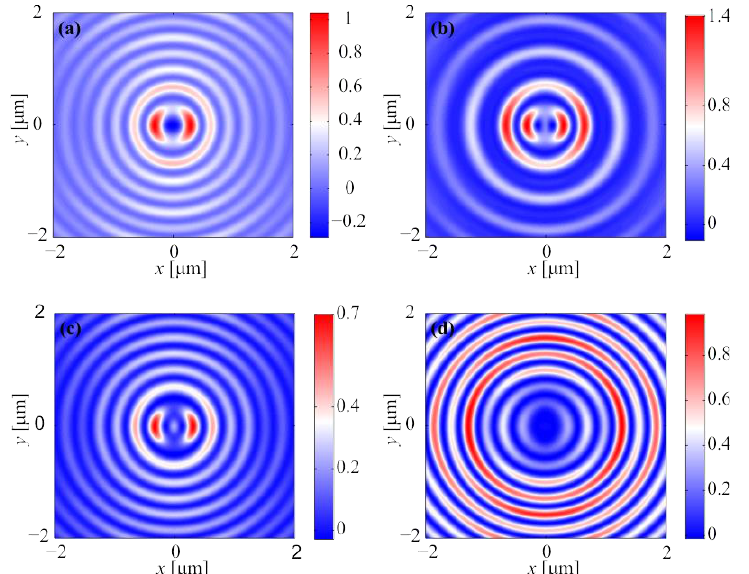
Figure 7. The instantaneous pattern of the longitudinal component of the Poynting vector S z of the second-order CVB in the focus of the BZP with relief from: aluminum with height of 50 nm ( a ), gold with height of 140 nm ( b ), chrome with height of 70 nm ( c ), and quartz with height of 532 nm ( d ).